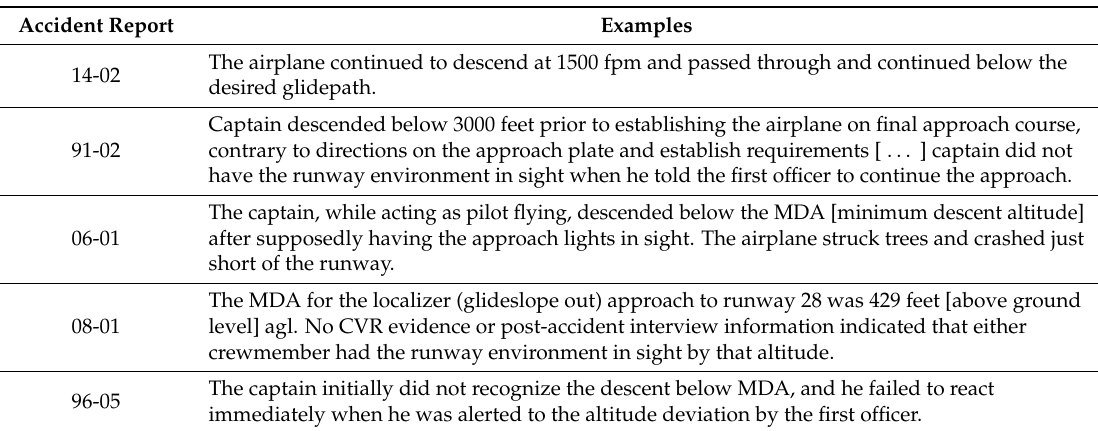
Table 7. Examples of Unauthorized Descent Below an IFR Altitude.